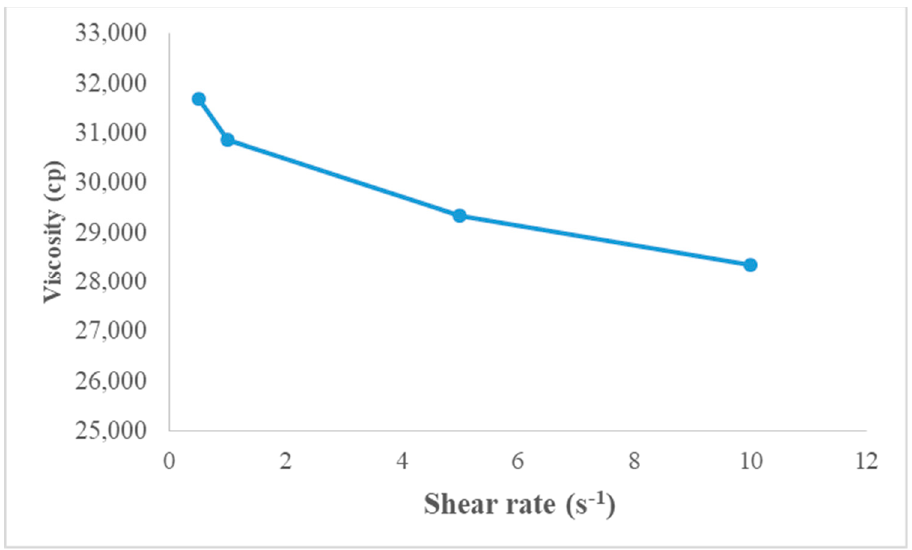
Figure 6. Apparent viscosity ( η ) vs. shear rate of P407 gel.